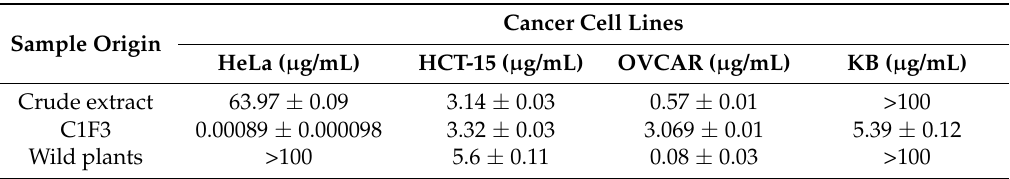
Table 1. Cytotoxicity (IC 50 ) of CH 2 Cl 2 :CH 3 OH crude extract and fraction C1F3 from hairy root line LRT 7.31 and wild plant extract of L. racemosa